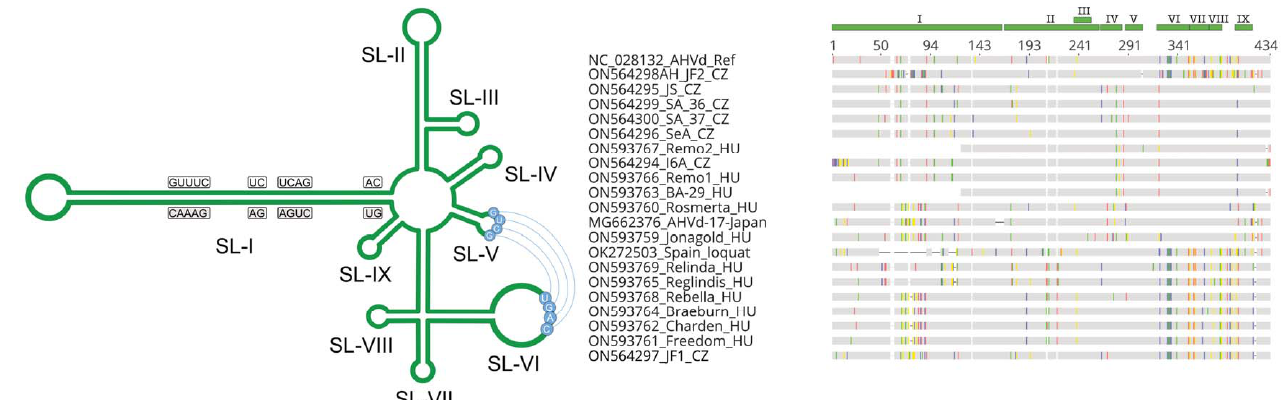
Figure 3. Molecular organization and alignment of AHVd variants, indicating the stem-loop structure (I-IX) above the sequence alignment and on the schematized AHVd structure. The structure cartoon was prepared using the verified secondary structure of AHVd [11].